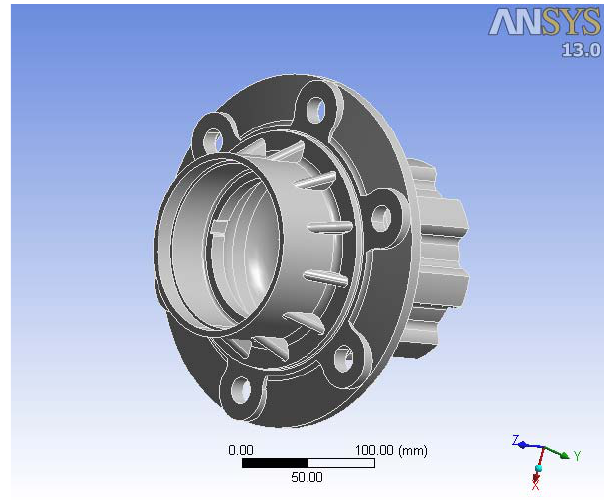
Figure 3. 3D model of the ZS061750 ‐ 152101 wheel hub.